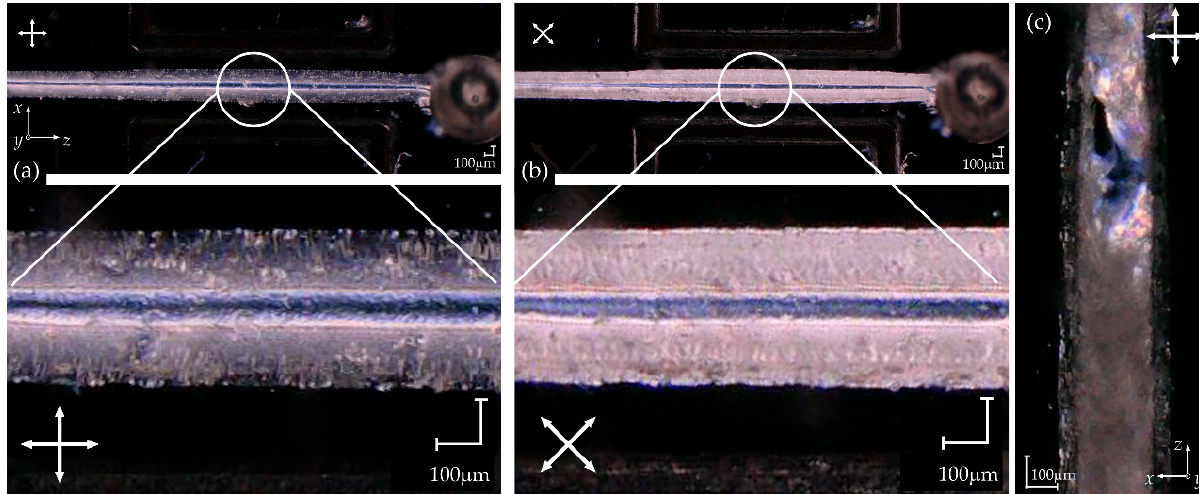
Figure 3. Photographs of the single microchannel (260-µm-wide) embedded in the PDMS:PDMS structure made with the 3D-printed mold. The channel observed 5 min after infiltration with an E7 NLC when aligned at angles of 0 degrees ( a ) and 45 degrees ( b ) to the crossed-polarizers axes. ( c ) Image of the same channel taken 3 days later.